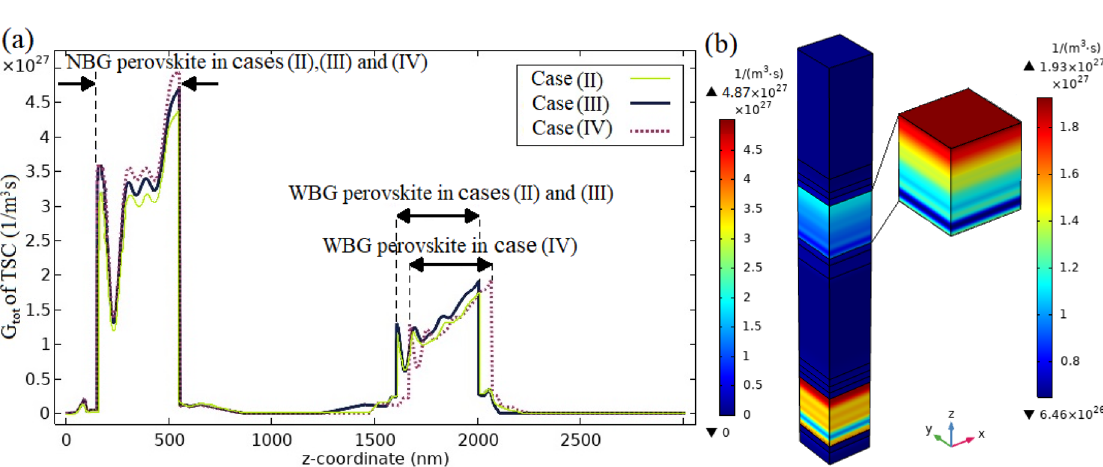
Figure 9. ( a ) 1D format of the photo generation rate distribution regarding cases (II)–(IV). ( b ) 3D profile of photo generation rate for case